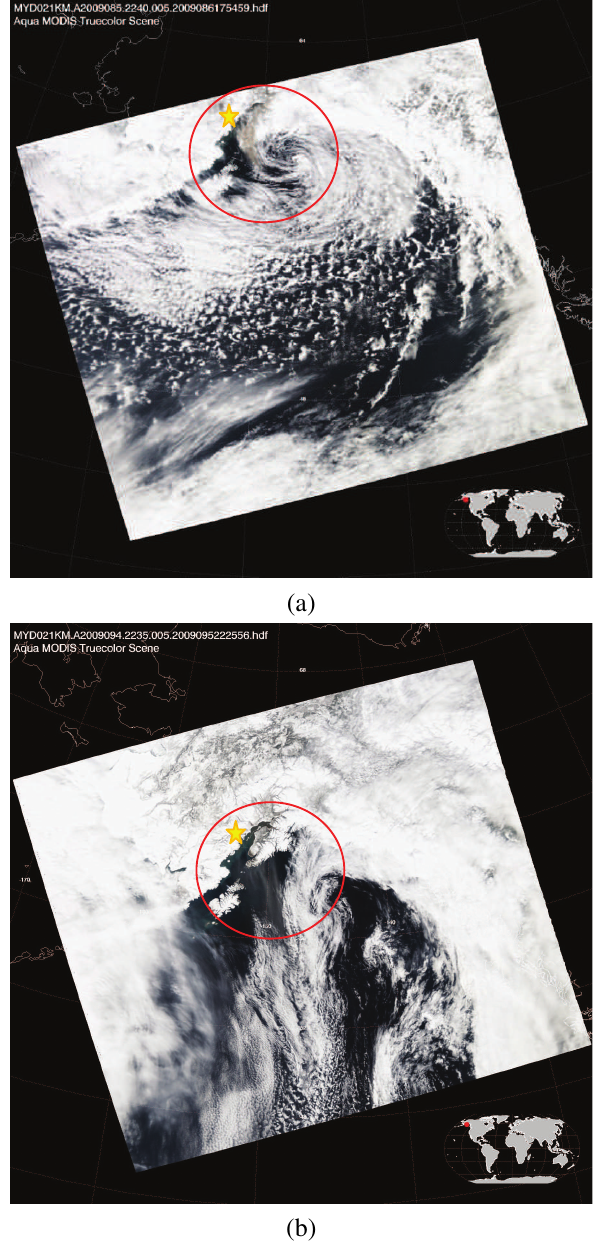
Fig. 1: (a) Spectral dependence of refractive indices of ash and sulfate. (b) Concentration normalized extinction coeffi- cients ( K ) versus wavelength for an ash rich mixture con- e Fig. 2. Aqua MODIS true color images on (a) 26 March at 22:40 taining an ash to sulfate ratio of 9 to 1 and an effective ra- UTC and (b) 4 April at 22:35UTC. The aerosol plume is circled in Fig. 2: Aqua MODIS true color images on (a) March 26 at red. The location of Mt. Redoubt is marked by a star. = 5 µ m compared to andesite with R = dius for ash R eff eff 22:40 UTC and (b) April 4 at 22:35 UTC. The aerosol plume 5 µ m (right axis) and for a sulfate rich mixture containing an is circled in red. The location of Mt. Redoubt is marked by a ash to sulfate ratio of 1 to 9 and an effective radius for ash star. R = 1 . 5 µ m compared to sulfate with R = 0 . 5 µ m (left eff eff axis). (c) Single scattering albedo ( ω ) versus wavelength for 0 an ash rich mixture containing an ash to sulfate ratio of 9 to = 5 µ m and a sulfate rich mixture containing an 1 and R eff